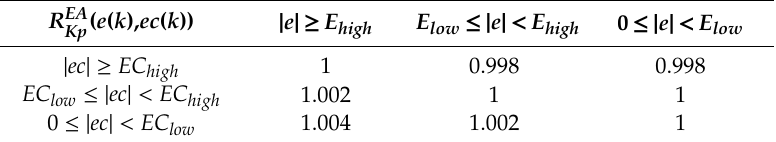
Table 3. Expert rule table of EA-PID for parameter K i .